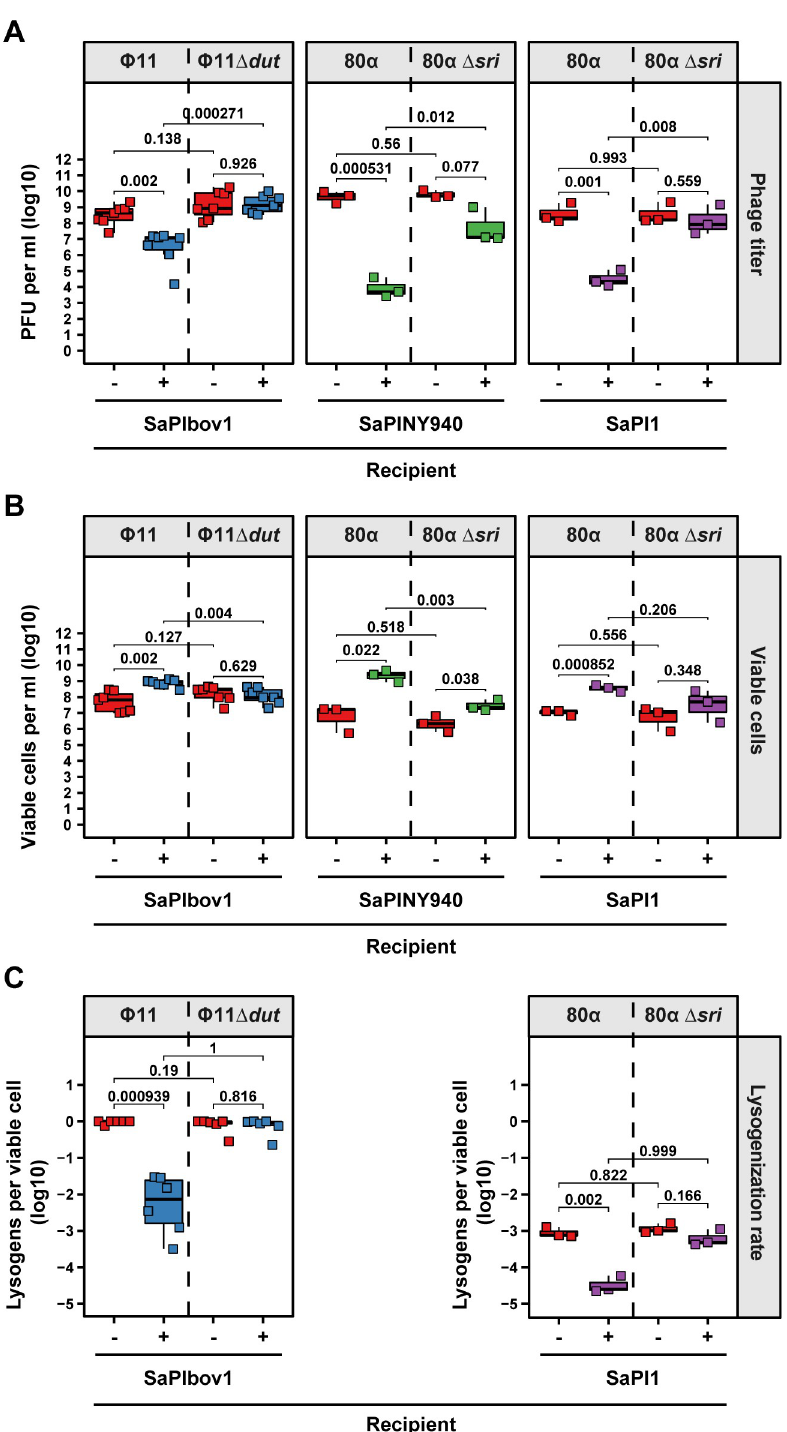
Fig 2. SaPIs reduce phage reproduction and lysogenization but increase cell viability. S . aureus RN4220 derivative strains either devoid of (red) or harboring either SaPIbov1 (blue), SaPINY940 (green) or SaPI1 (purple) were infected with an MOI of 1:10 (phage:bacteria) of the indicated phages. Phage titers (A) , viable cells (B) and the relative number of lysogens per viable cell (C) for each recipient were determined. Note that the number of lysogens could not be determined for SaPINY940 due to an incompatibility of selection markers. Bold horizontal lines in each boxplot represent the median and lower and upper hinges the first and third quartiles, respectively (n = 7 biological